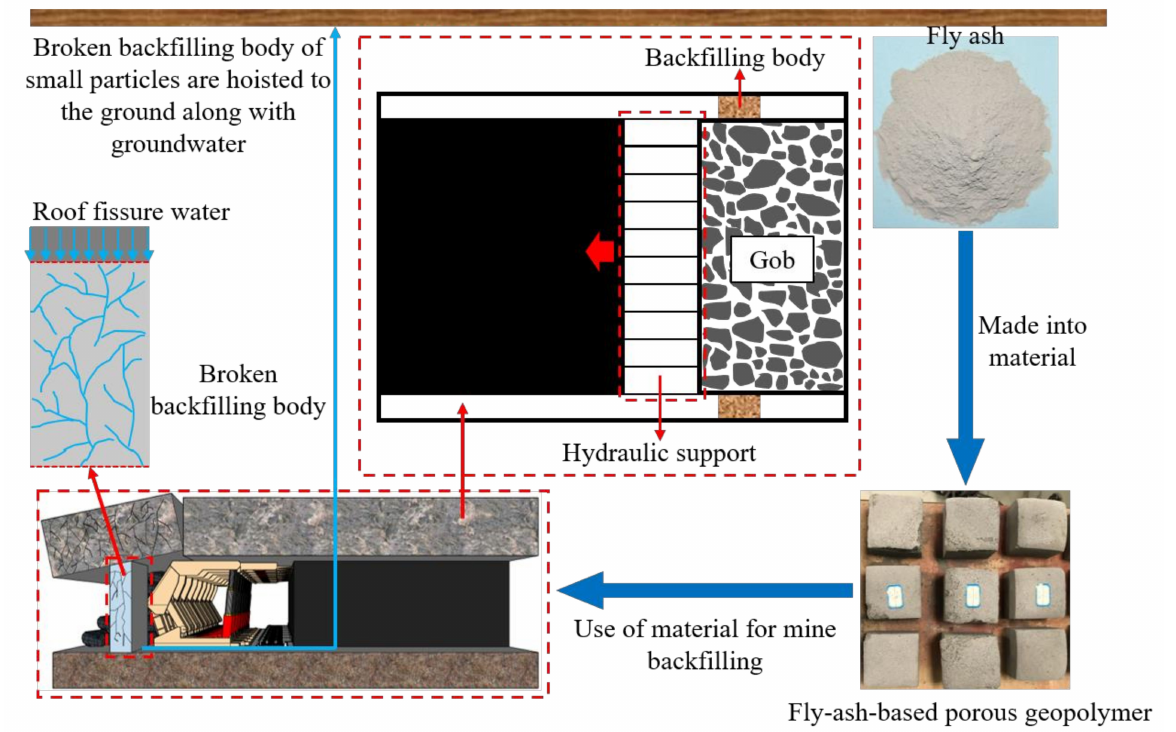
Figure 1. Face end backfilling in the coal–electricity integrated industry